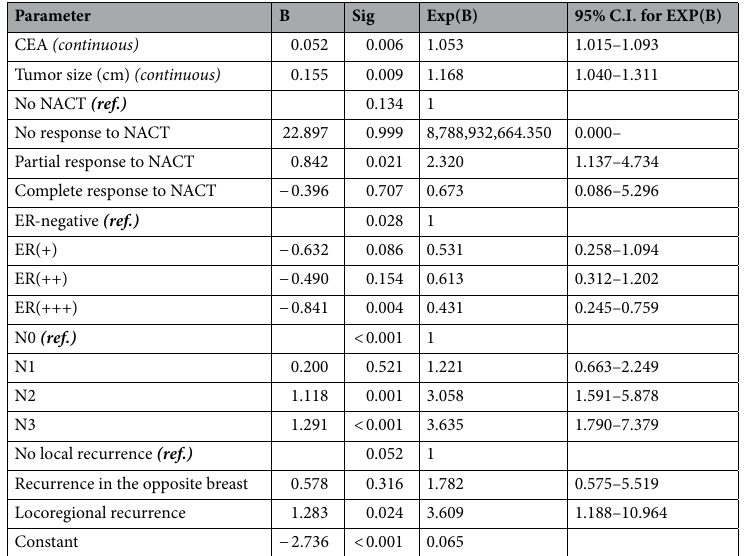
Table 6. Multivariate logistic regression analysis of demographic, therapeutic, and histopathologic parameters between Groups 1 and 3. NACT neoadjuvant chemotherapy, N nodal